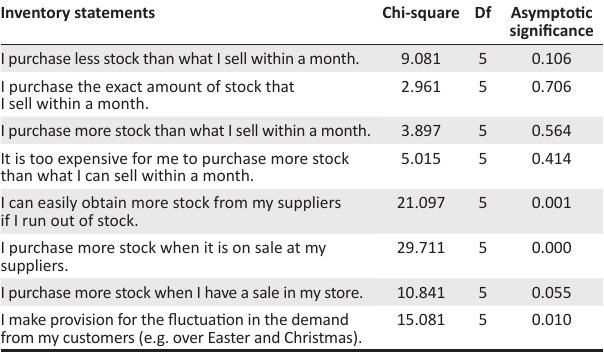
TABLE 11: Kruskal–Wallis test results on Hypothesis 2.